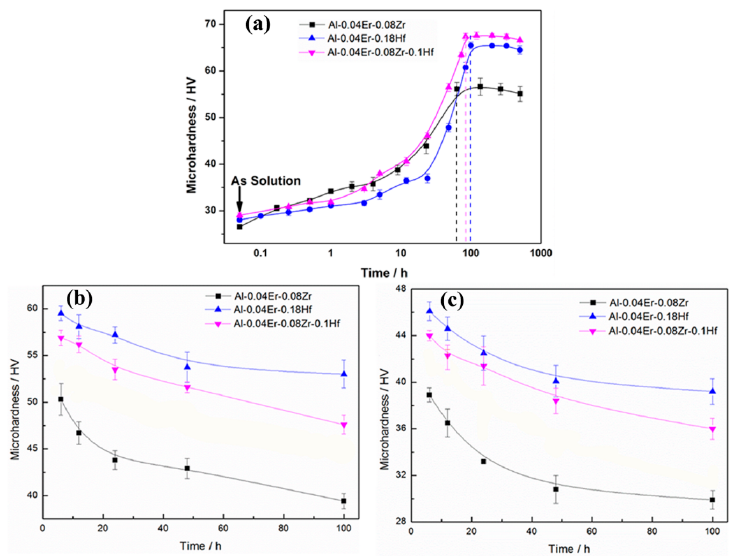
Figure 1. Microhardness evolution vs. exposure time: ( a ) at 350 °C (Reprinted/adapted with permission from Ref. [17]. 2015, Elsevier. ©); ( b ) at 450 °C after annealing at 350 °C to the peak hardness state, and ( c ) at 500 °C after annealing at 450 °C for 100 h.